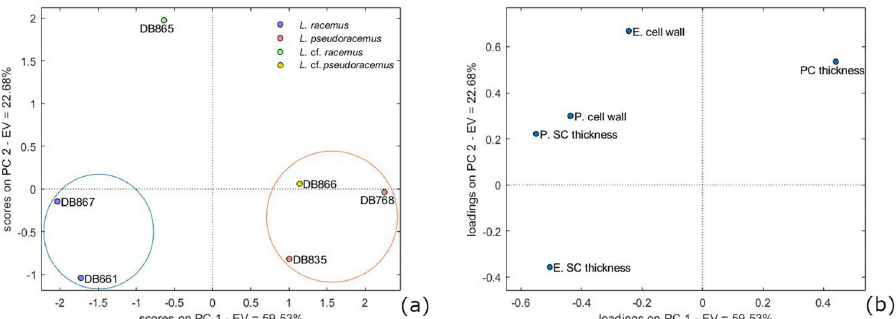
Fig 8. Principal component analysis (PCA). Score plot is shown in (a); loading plot of PCA on calcification data in both perithallial (P.) and epithallial (E.) cells (b). The plots model 83% of the total data variance. Variance proportions are shown along each component axis. Calcification types are evidenced with circles and classified in L . racemus type and L . pseudoracemus